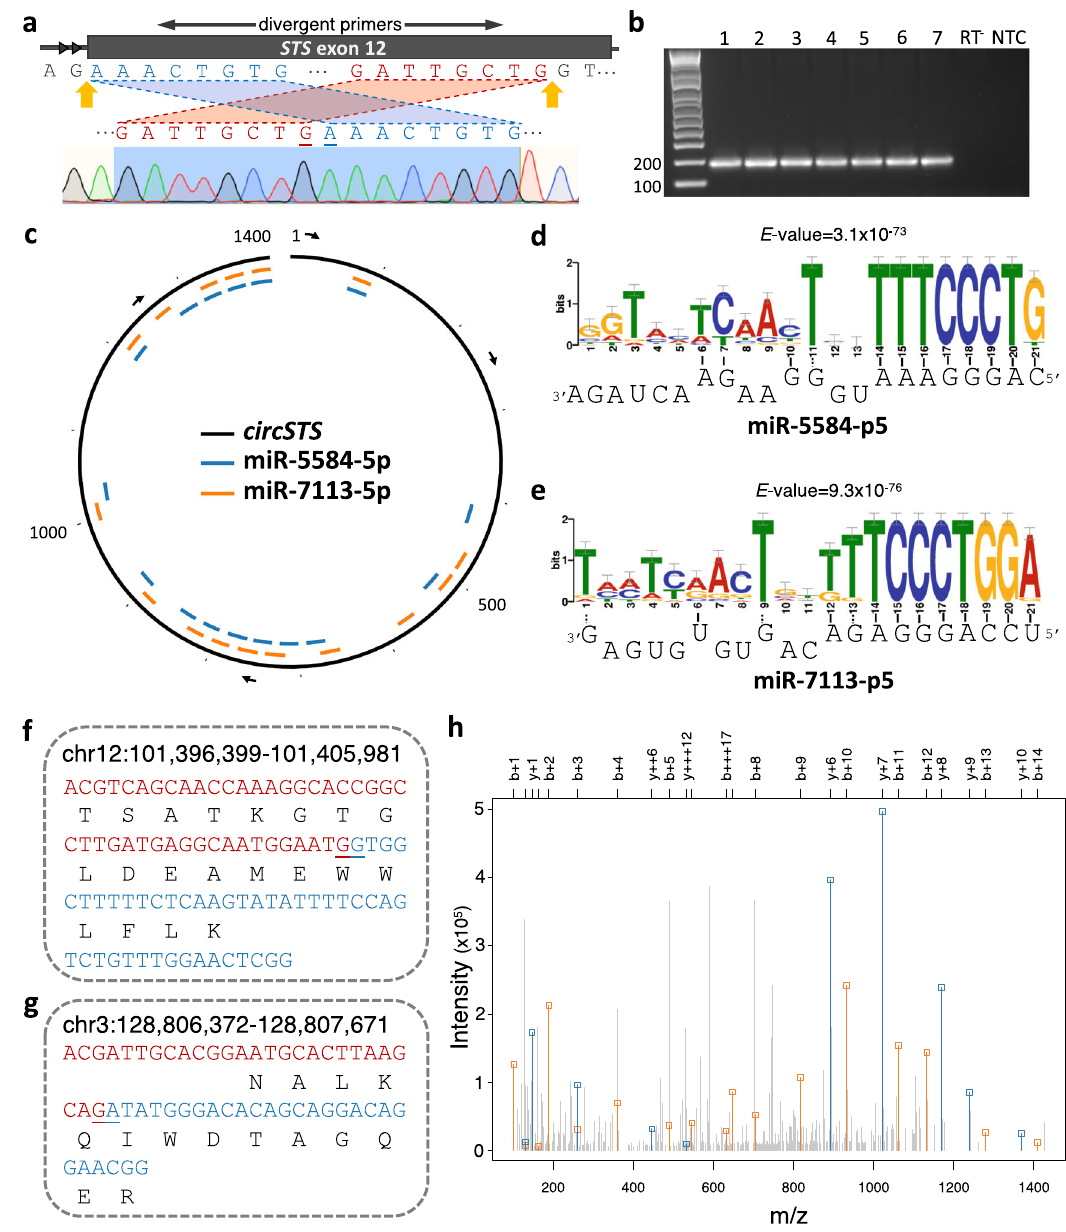
Fig. 3 circSTS as a putative miRNA sponge and evidence of peptides translated from circRNAs. a The back-spliced positions (indicated in yellow arrows) are within the 12th exon (thick rectangle) of a lincRNA (ENST00000658154) encoded by STS . Back-splicing was assayed with divergent primers (top) and con fi rmed by Sanger sequencing (bottom). The fi rst and last 8-bases, colored in blue (5 ’ ) and red (3 ’ ) respectively, are fl anked by AG/GT (intronic acceptor/donor sites). b The expected size of the back-spliced PCR product from circSTS (170 bp) was validated by qPCR from seven placental samples. RT - : no reverse transcriptase; NTC: no template control. Source data are provided as a Source Data fi le. c circSTS (chrX:7,514,882-7,516,290) is represented as a black open circle with its putative binding sites for miR-5584-5p (blue) and miR-7113-5p (orange). Its relative base positions are marked for every 100th-base position and 1st, 500th, 1000th, and 1400th positions are numbered. The arrows indicate 5 ′ -to-3 ′ direction. Sequence motif analyses of miR-5584-5p and miR-7113-p5 are shown in ( d ) and ( e ) respectively, with the corresponding sequence miRNAs shown at the bottom. The size of the sequence logo represents how well the binding base is conserved across the 16 predicted binding regions represented in ( c ). f – g Peptidomic evidence for translation of two circRNAs. The putative peptides are in black and the bases on either side of the BSJ are colored in red (5 ′ ) and blue (3 ′ ). The peptides were translated across the BSJ (indicated by underlines) of circRNAs. h Mass spectrum corresponding to the peptide sequence of ( f ). On the x -axis, the mass/charge ratio of the peptide fragments is shown, with the intensity on the y -axis. Peaks that can be attributed to b and y -ions (i.e., including the N- and C- termini respectively) of the peptide are indicated with a square and colored in red and blue respectively.